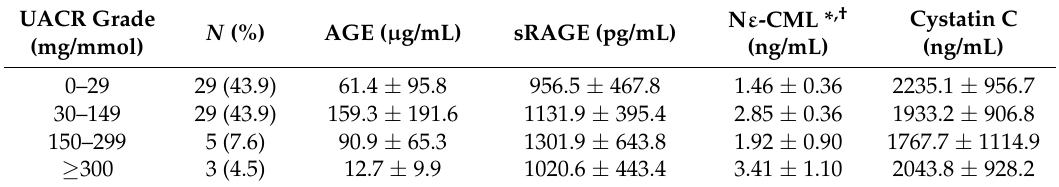
Table 2. Comparison of serum biomarkers between urine microalbuminuria (UACR) grades. UACR